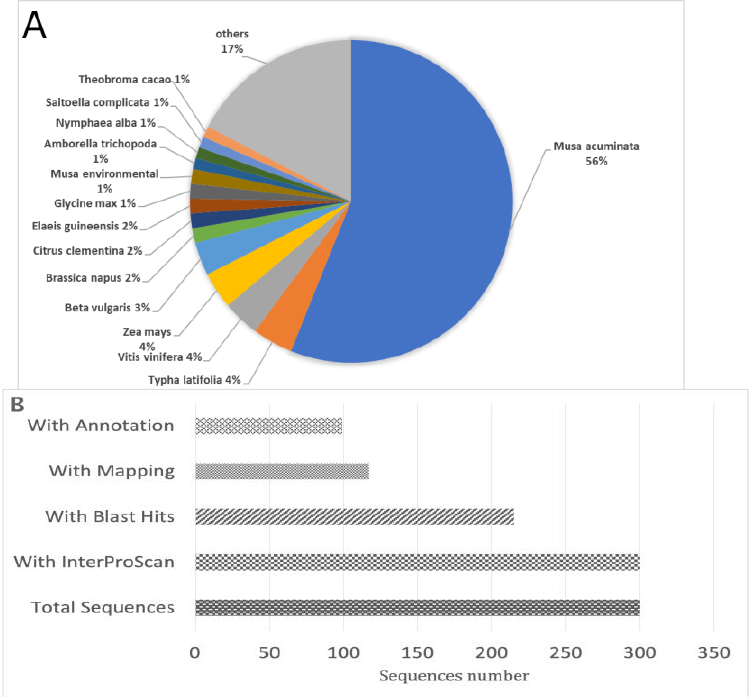
Figure 2. Statics Analysis of Sequences. ( A ) Top Hits BLAST of Representatives Species by BLAST2Go; ( B ) Statics a different level of analysis in the sequences by BLAST2GO.